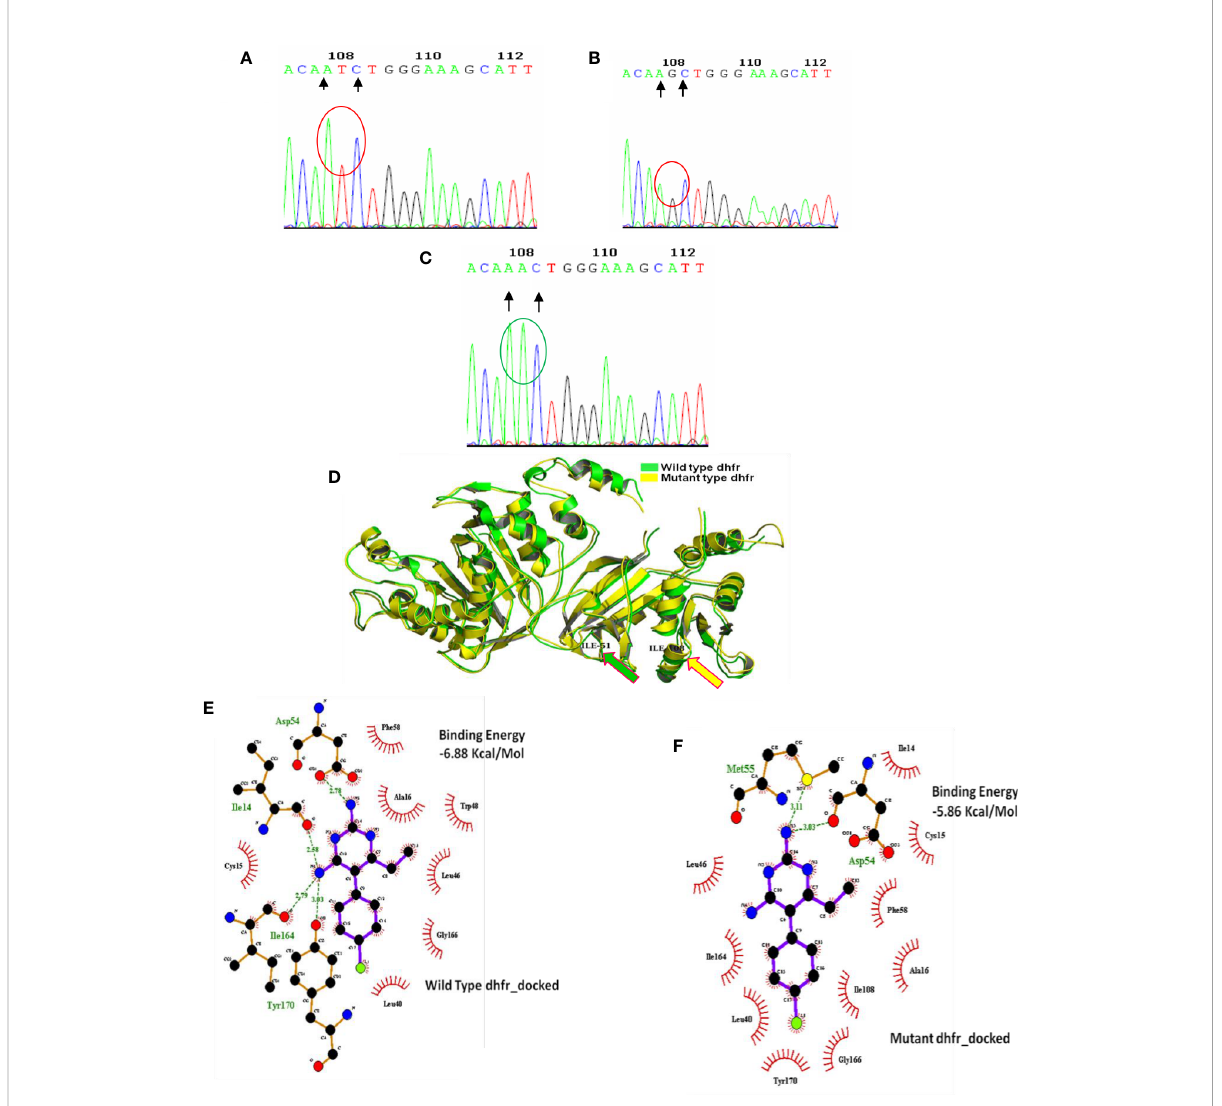
FIGURE 3 Genomic and proteomic analysis of mutant dhfr 108 codon. Through DNA sequence analysis, an alteration of AGC (B) to ATC (A) was observed at codon 108, which encoded mutant isoleucine (108I) (A) . The Expert Protein Analysis System con fi rmed the presence of isoleucine (ATC). In the wild-type allele, AGC expresses serine at 108 positions of dhfr gene, but after mutation, it was replaced with AAC (encoding asparagine) (C) . (D) Superimposition of wild and mutant allele: Super-imposition of wild and novel double dhfr mutation (108I + 51I) proved the uniformity of mutant allele with the wild allele except at 51, and 108 codon and producing a notch having a RMSD of 0·438 Å. (E) Molecular docking of pyrimethamine with wild- type dhfr gene. (F) Molecular docking of pyrimethamine with novel double mutant ( dhfr- 108I+51I) allele. Docking with wild- type dhfr protein with pyrimethamine produced high binding energy of 6.88 Kcal/Mole, whereas the docking of double mutant dhfr protein with pyrimethamine produced much less binding energy of 5.86 Kcal/Mole. It proves the less af fi nity of novel mutant dhfr protein toward